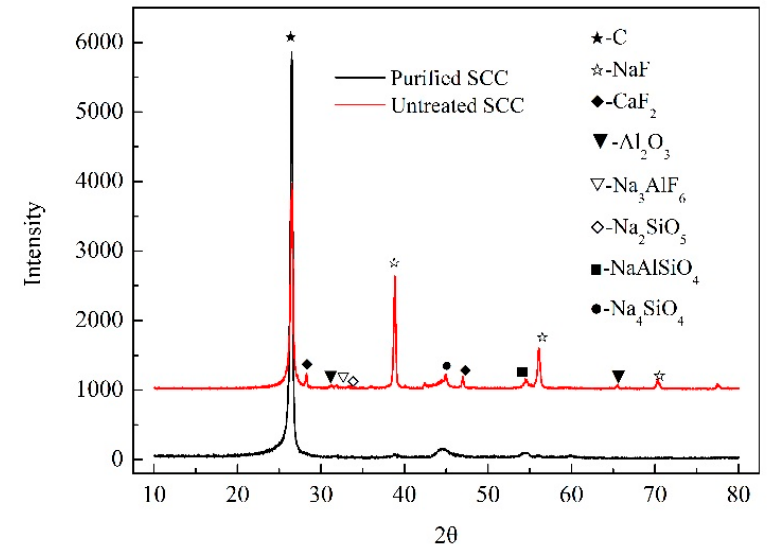
Figure 8. XRD patterns of SCC.